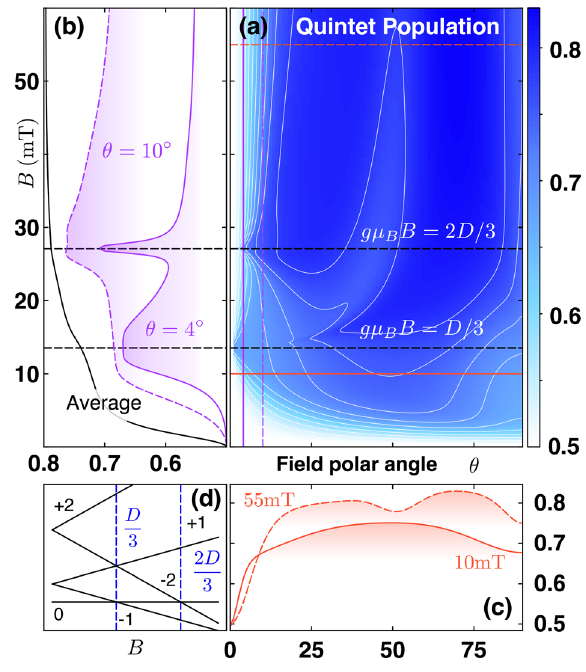
Fig. 3 Effect of magnetic fi eld on quintet formation driven by stochastic conformational switching. a Quintet population p 5 ( t ) at t = 2000 h / D ≈ 1.76 μ s ( h Planck ’ s constant, D the ZFS parameter) as a function of the fi eld polar angle θ and the magnetic fi eld strength B . g is the electron g-factor and μ B the Bohr magneton. b Slices of p 5 ( t ) for fi xed angles as a function of B , with the weighted average of p 5 over all angles in black. The peaks in the θ = 4° slice correspond to the level crossings shown in panel ( d ). c Slices of p 5 ( t ) for fi xed fi eld strength as a function of θ . The dips at θ = 0°, 54. 7°, and 90° occur where some 5 (TT) eigenstates cannot mix with 1 (TT) 30 . d Quintet energy levels vary with magnetic fi eld strength, with fi eld direction ^ e B parallel to the molecular z -axis ^ z M . Any deviation in ^ e B causes the crossings to become avoided, allowing more than one state to mix with 1 (TT). See Supplementary Note 1 for parameters of the spin 5 (TT) populations saturating at 3/4, since only three 5 (TT) states mix with 1 (TT) as predicted by Smyser et al. 30 .